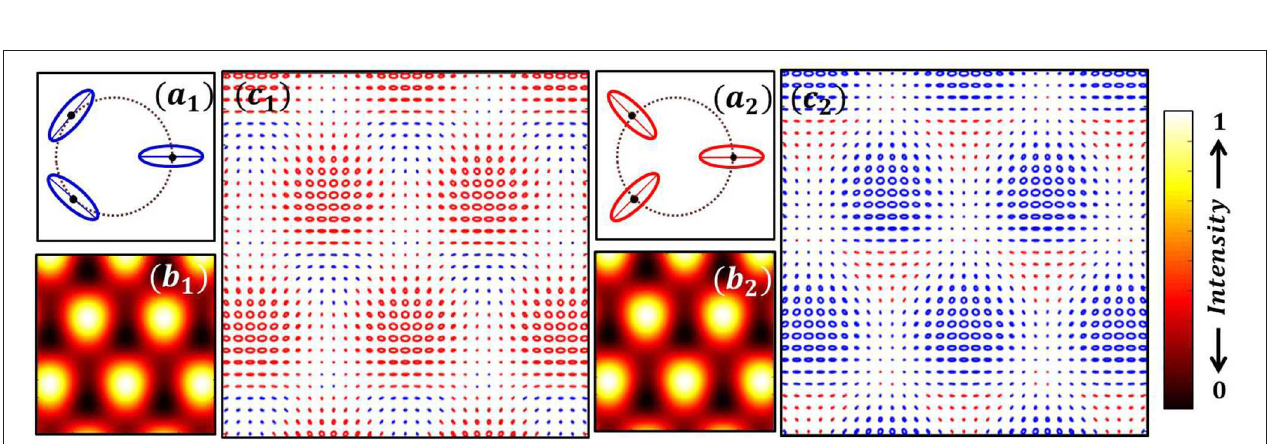
FIGURE 9 | Six Beam Interference: SOPs of the interfering beams are selected from V-points represented by the equatorial points of HOPS ( η = 2). (a–d) Simulation; (a ′ –d ′ ) Experimental results.